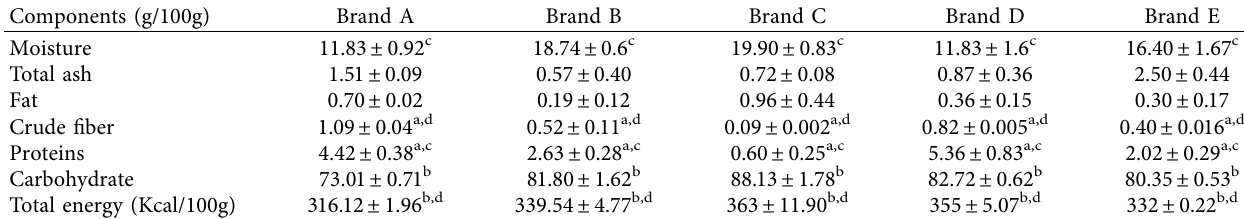
Table 1: Proximate analyses of different brands of Chyawanprash (average ± standard